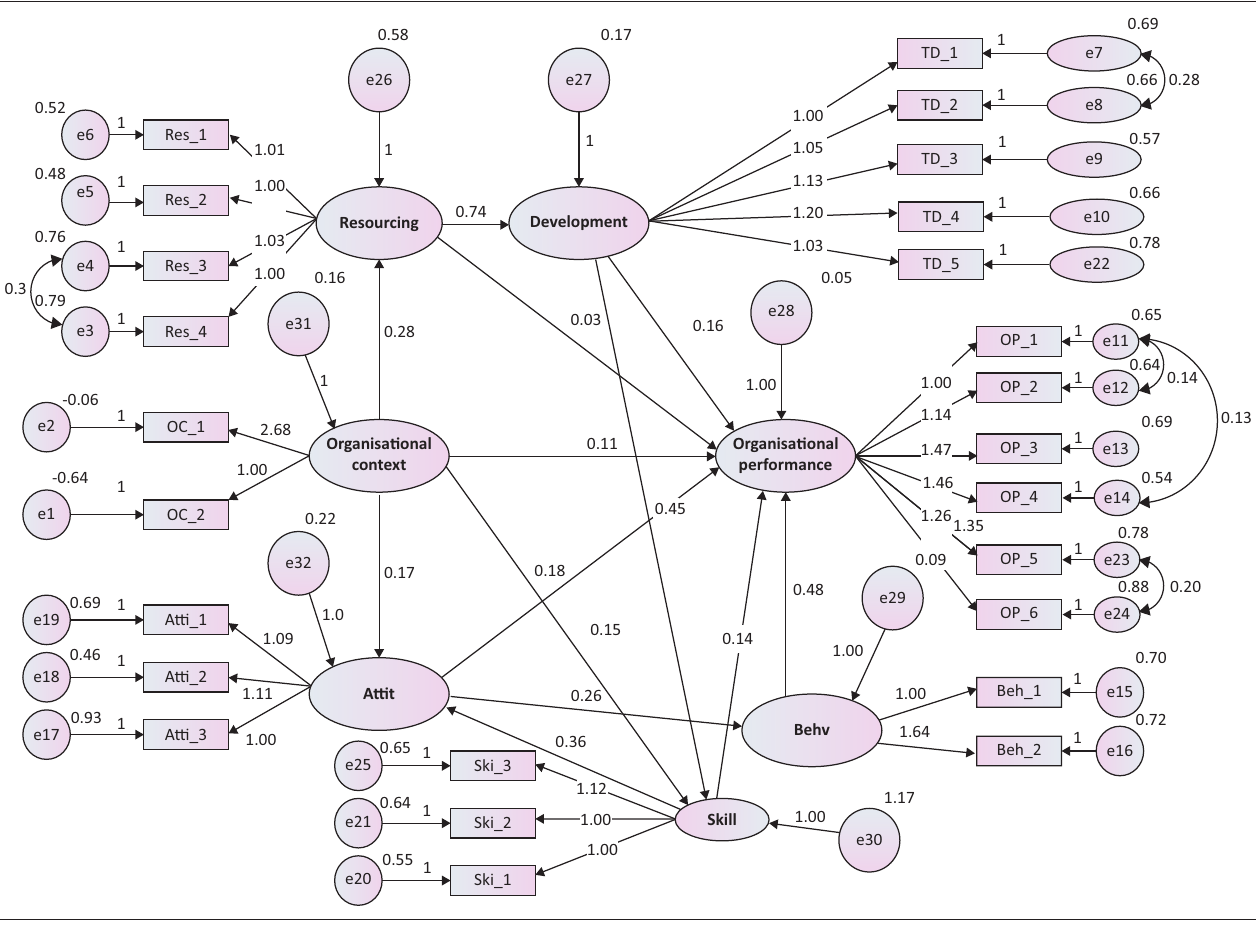
TD, Training and development; OP, Organisational performance ; Behv, Behaviour; Attit, Attitude; Ski, Skills; Res, Resourcing. FIGURE 2: Estimated model using structural equation